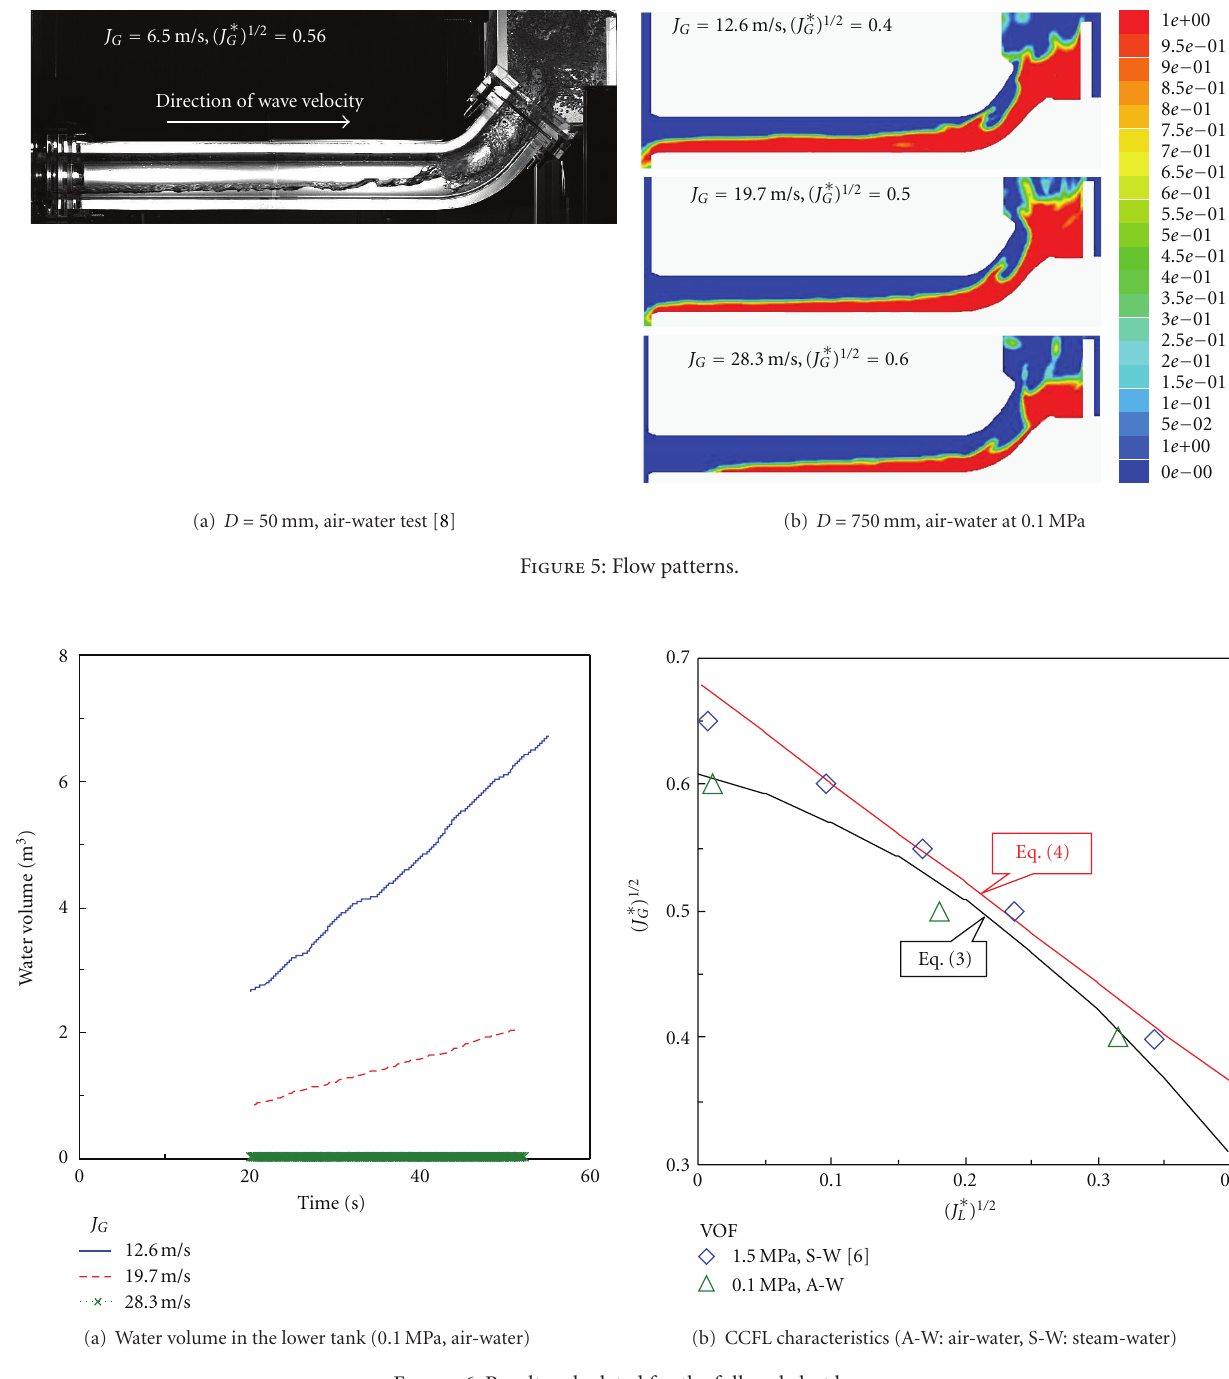
Figure 6: Results calculated for the full-scale hot